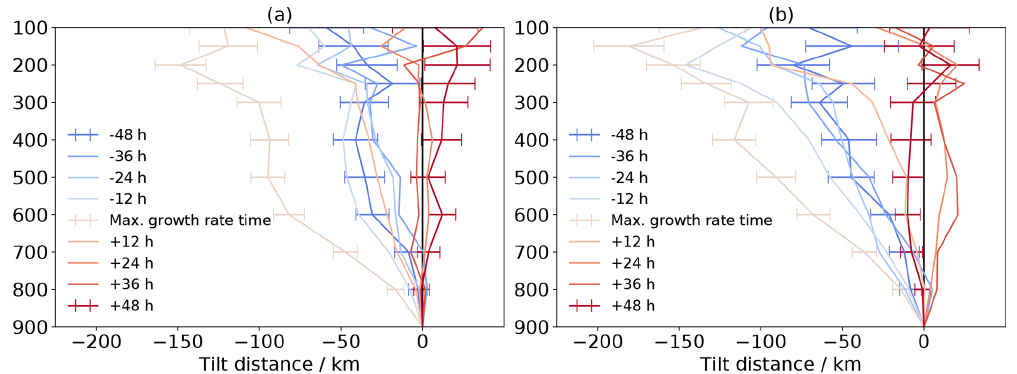
Figure 11. Evolution of composite vorticity tilt structure from 48h before to 48h after the time of the maximum growth rate for the 200 most intense (a) matched and (b) unmatched cyclones. Illustrative standard error bars are shown at three times. Tilt distance is the great-circle distance relative to the ξ centre at 900hPa, and the y axis is pressure (in